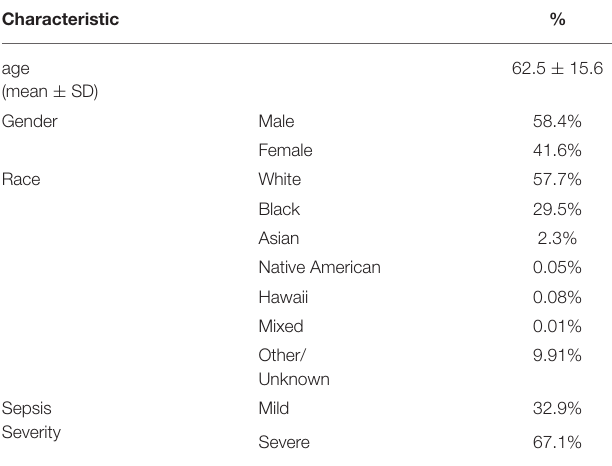
TABLE 1 | Demographic characteristics of the studied